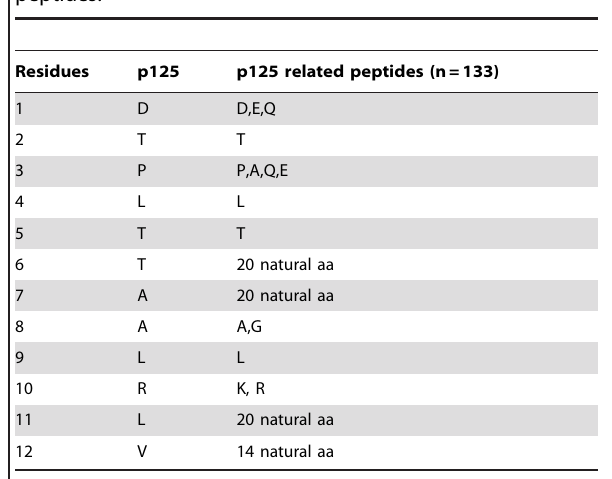
Table 2. Amino acid substitution of 8H5-reactive 12mer peptides.